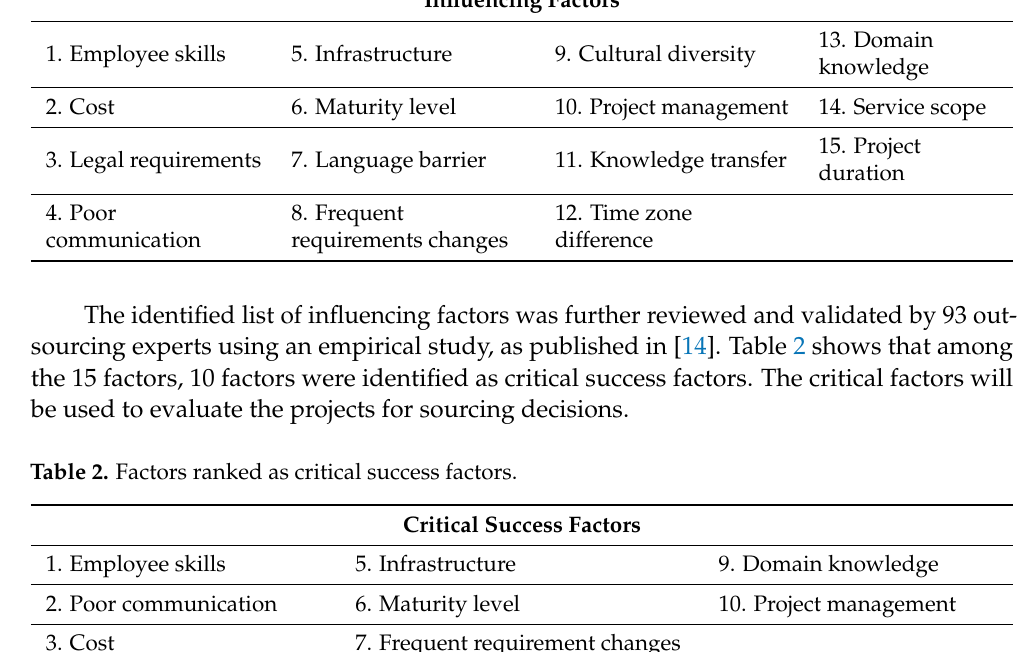
Table 1. List of influencing factors.